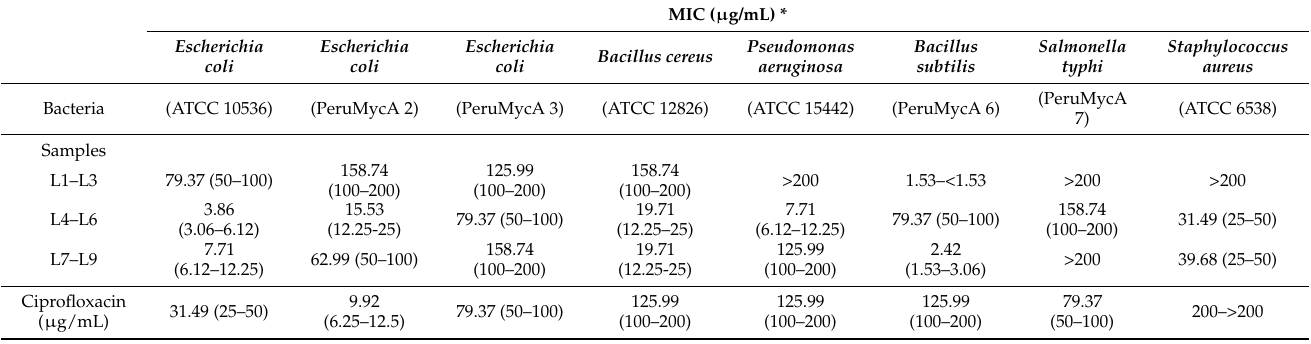
Table 6. Minimal inhibitory concentrations (MICs) of F. officinalis samples against bacterial isolates. MIC ( µ g/mL) *